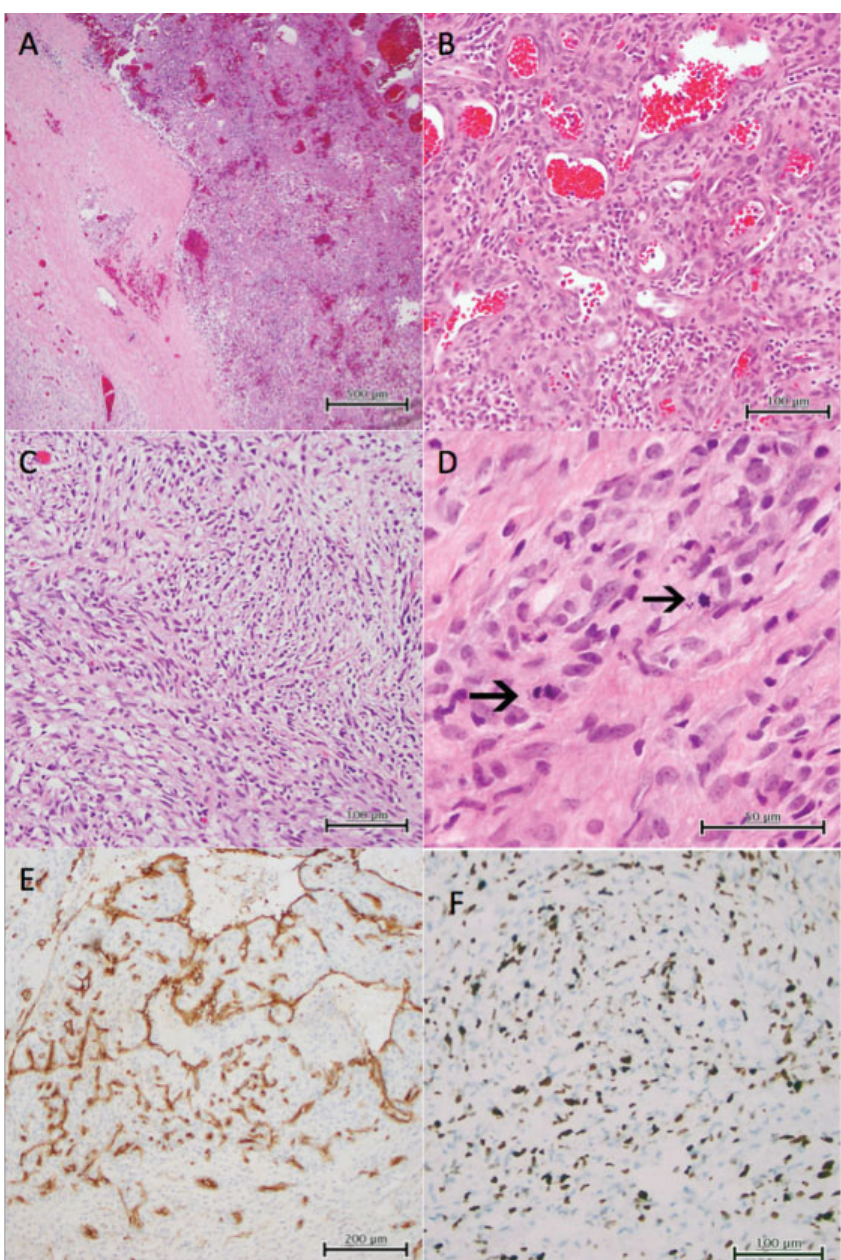
Fig. 3 Histopathological studies. ( A ) Low-power photomicrograph showing the abrupt transition between the central, vascular portion of the tumor and the outer rim of myo fi broblastic atypical spindle cell proliferation. ( B ) High-power photomicrograph showing vascular portion of the tumor. ( C ) High-power photomicrograph showing spindle cell portion of the tumor. ( D ) High-power photomicrograph showing prominent mitotic activity in the spindle cell portion of the tumor. ( E ) Low-power photomicrograph showing CD34-positive vascular channels within the spindle cell portion of the tumor. ( F ) Photomicrograph revealing K i -67 proliferation index of 40 to 50% in the atypical spindle cell tumor